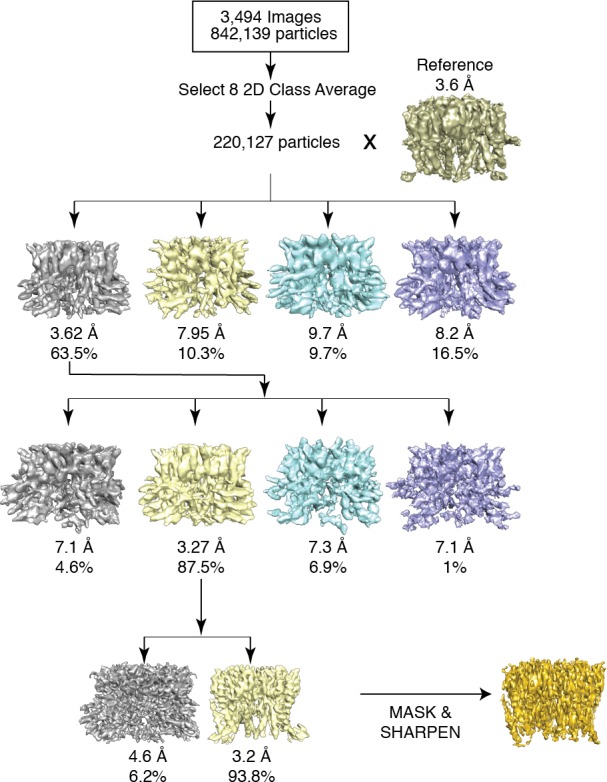
Single particle data processing.842,139 particles were automatically selected to generate a 2D class average. Eight classes were selected; a reference from a previous dataset that generated a 3.6 Å map was used to derive four initial classes. The four classes were generated from automatic refinement; one class was selected to generate an additional round of four classes. The subsequent particle was then selected to generate two more classes (two more rounds with a mask to omit contributions from the amphipol). The final, highest resolution structure was selected and then sharpened.